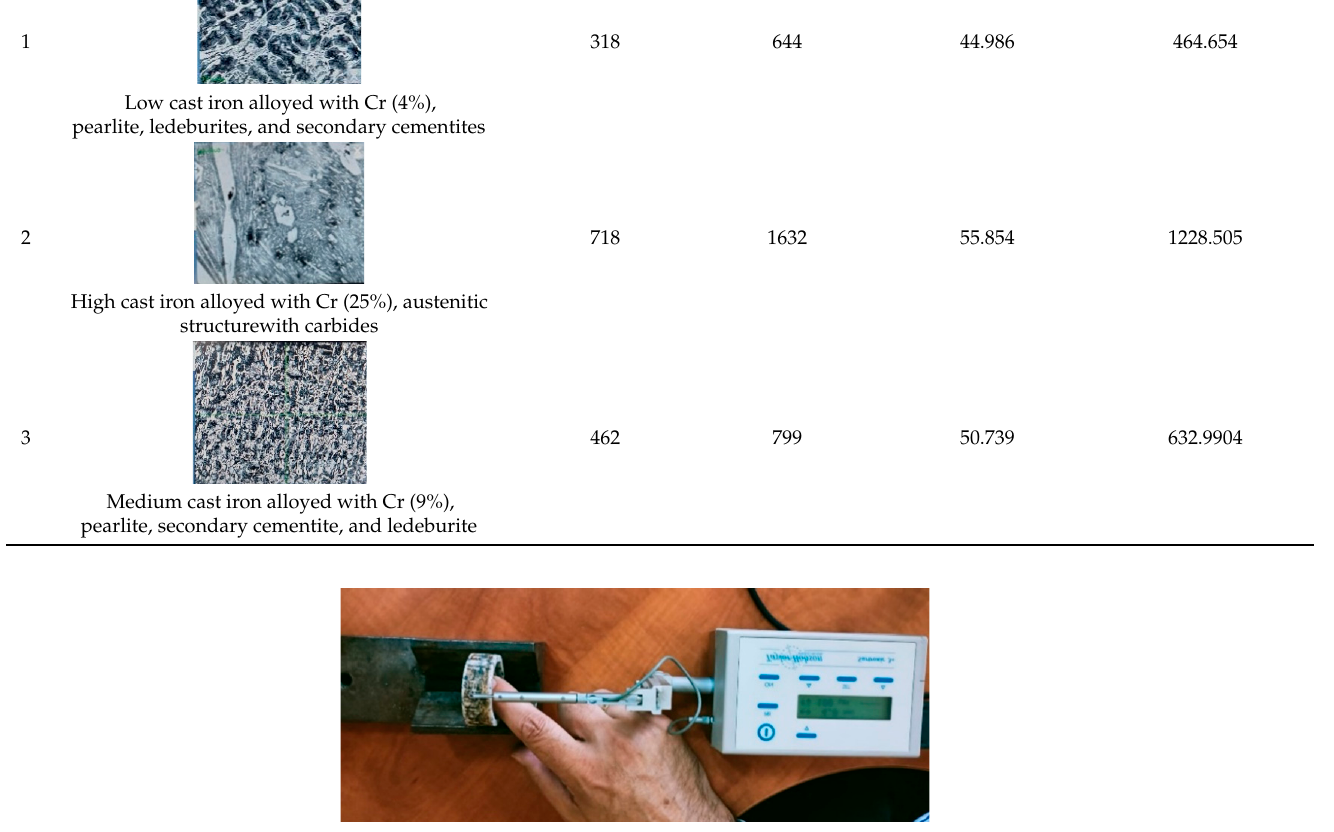
Figure 4. The SURTRONIC 3+ type profilometer—the measurement process.